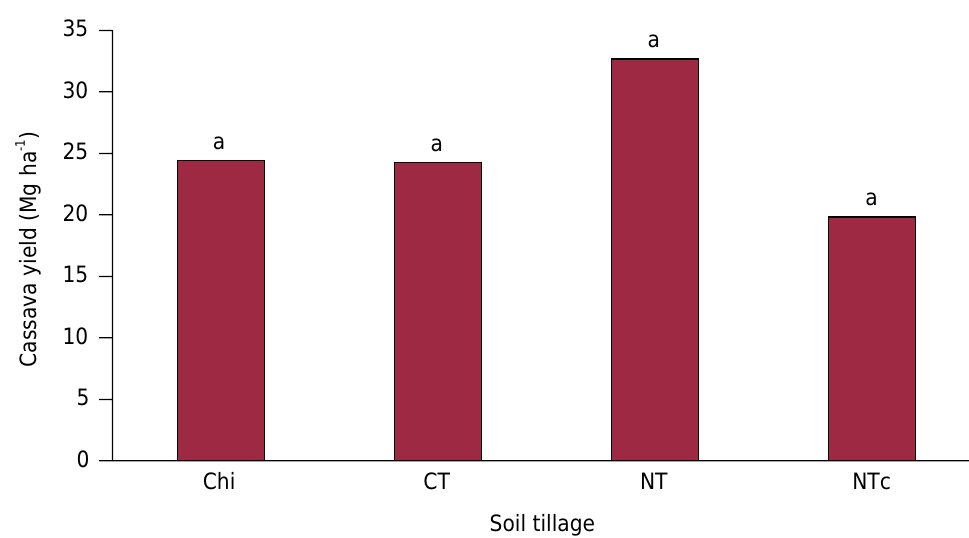
Figure 8. Yield of cassava storage roots, for chisel plough (Chi), conventional tillage (CT), no-tillage (NT), and compacted no-tillage (NT C ). Means followed by same letter do not differ (DMS test, 5 % probability